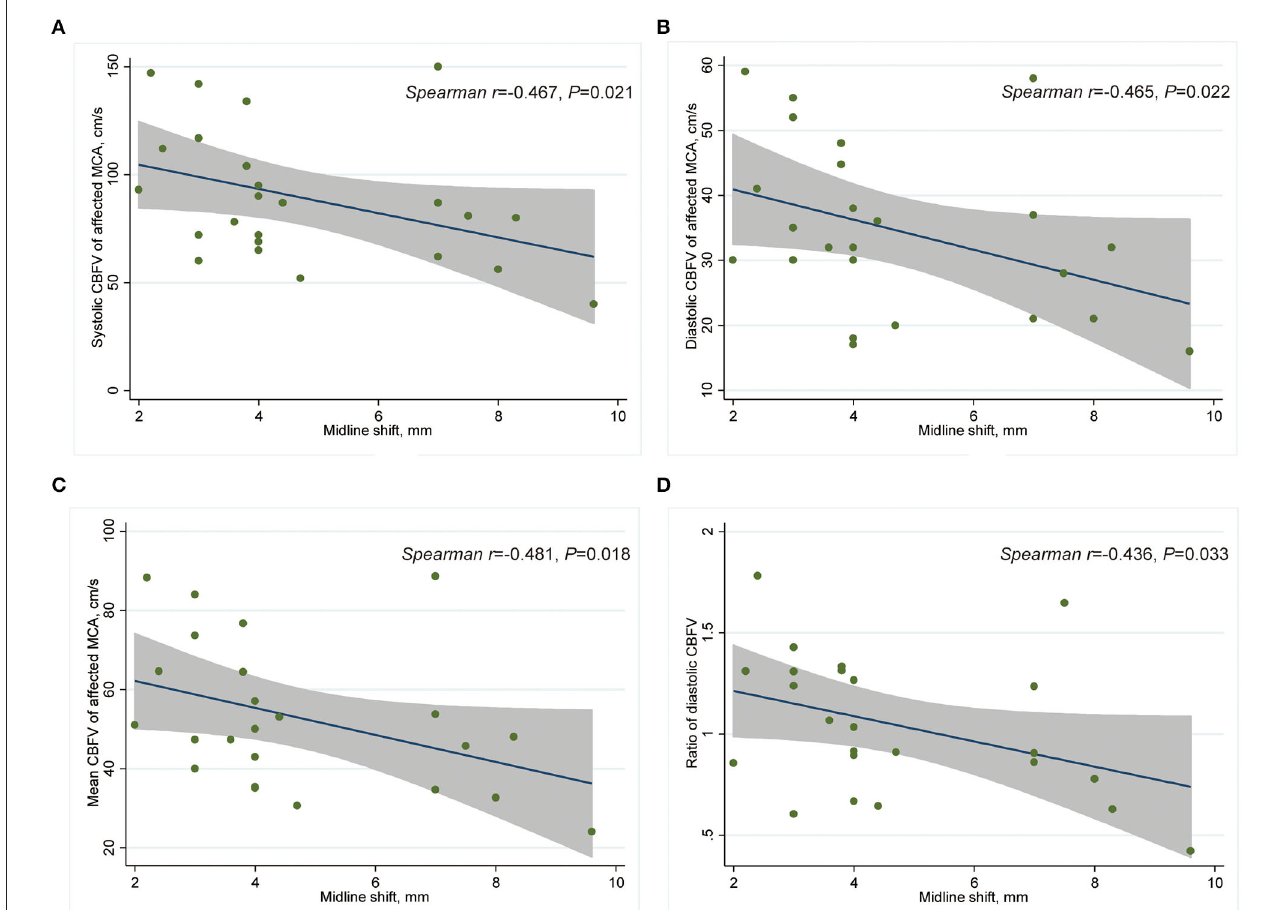
FIGURE 3 | Scatter plot showing correlation between CBFV and MLS in patients with CED-3 ( n = 24). (A) Systolic CBFV of the affected MCA and MLS; (B) diastolic CBFV of the affected MCA and MLS; (C) mean CBFV of the affected MCA and MLS; (D) and affected/contralateral ratio of diastolic CBFV and MLS. CBFV, cerebral blood flow velocity; CED, cerebral edema; MCA, middle cerebral artery; MLS, midline shift.